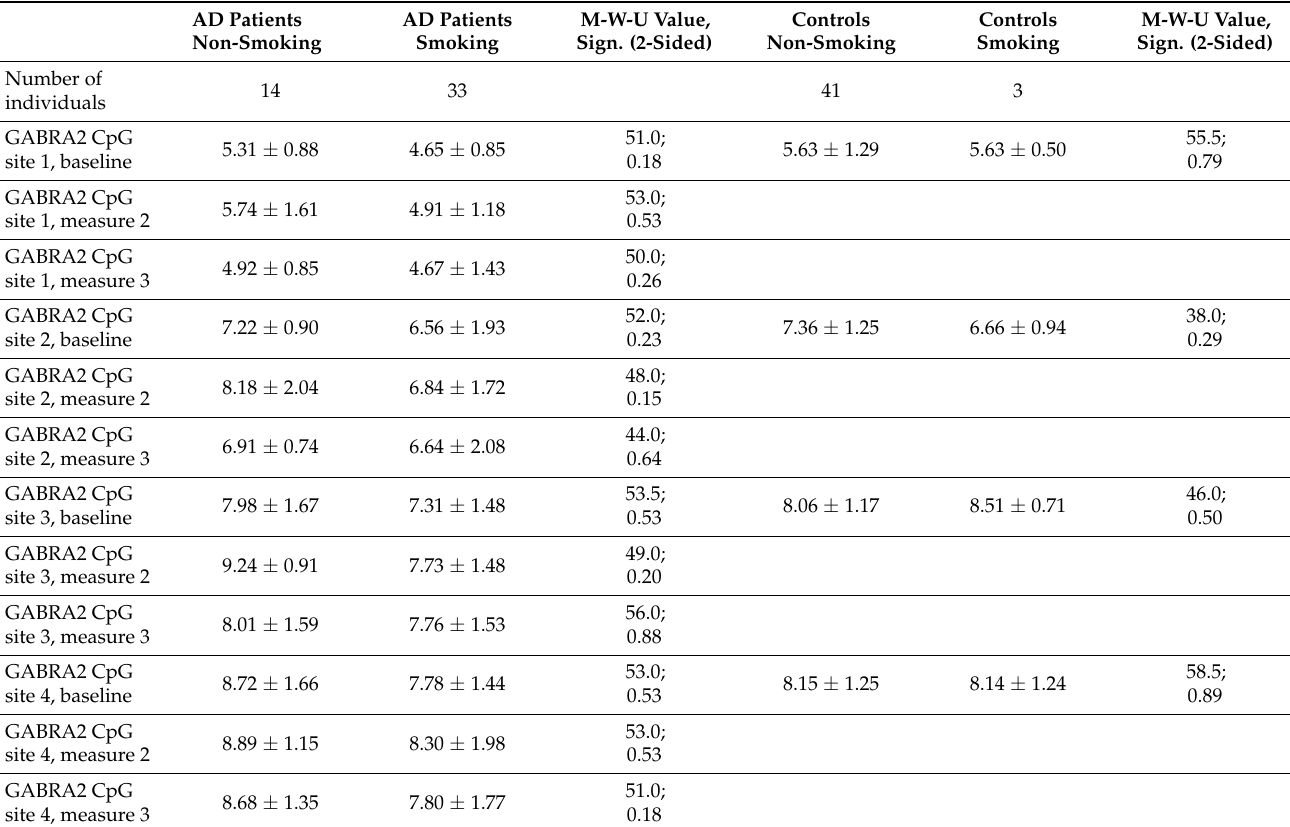
Table 3. Smoking Status and GABRA2 CpG Site Methylation in Alcohol-Dependent Patients and